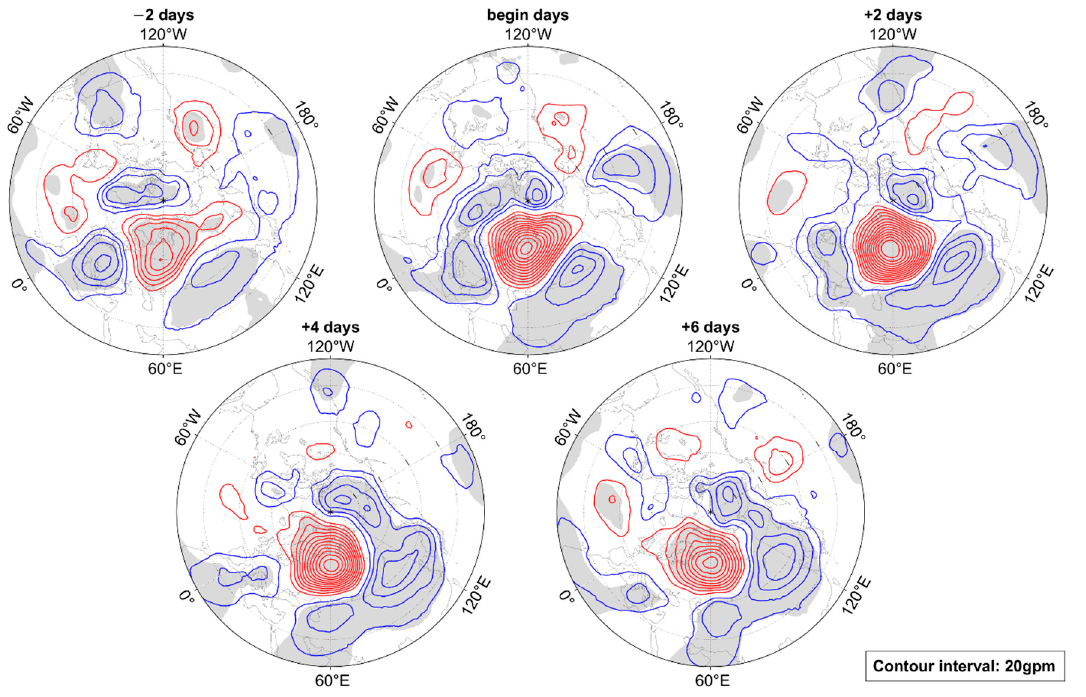
Figure 5. Synthetic analysis of the 500 hPa HGT anomaly field before and after the occurrence of the Ural Mountains blocking highs in the extended winter of 1979–2020 (the red line indicates a positive anomaly value, and the blue line indicates a negative anomaly value, grey shaded area through the test of significance of 95%).